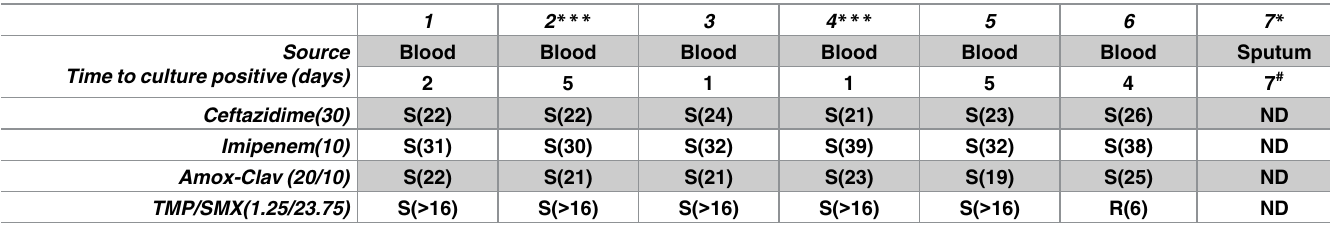
to hospital in June with fever (39˚C), dyspnea, anorexia, malaise, abdominal pain, and diarrhea (S1 Table). Upon admission, he was tachycardic (128 bpm) and tachypneic (28 breaths per minute). Blood tests showed marked leukopenia with granulocyte predominance, hyponatre- mia, and hypokalemia (Table 1A). The patient was treated initially with ampicillin (1g IV q8h) and ceftriaxone (3g daily IV), followed by gentamicin (240 mg IV×1 dose). The patient died 25 hours after enrollment. The patient’s blood culture grew gram-negative bacilli 24 hours later, which were isolated on Ashdown’s medium. Biochemical and PCR identification of the isolate confirmed B . pseudomallei (Table 2).